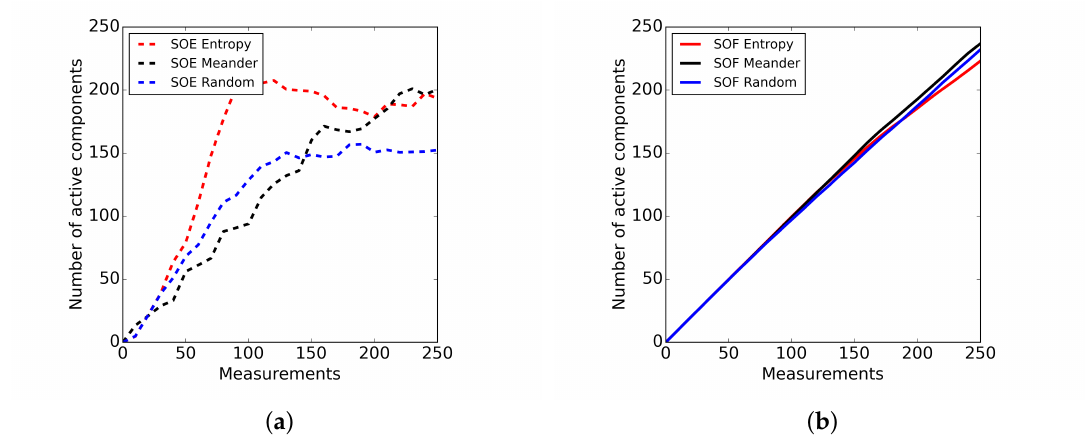
Figure 5. ( a ) Active components for SOE (dashed) for 10 agents averaged over 10 runs; ( b ) active components for SOF (solid) for 10 agents averaged over 10 runs.